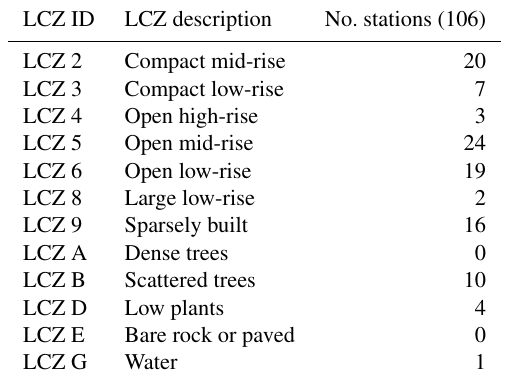
Table 2. LCZs present in Leuven and the number of weather sta- tions in each LCZ